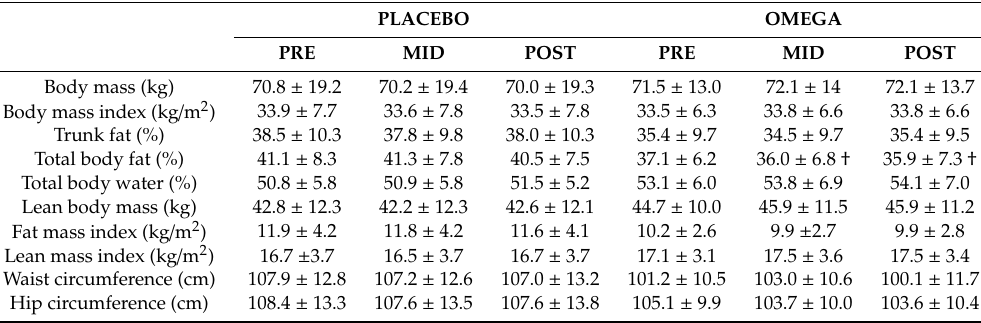
Body composition indices at pre, mid (3mo) and post (6mo) of placebo or omega